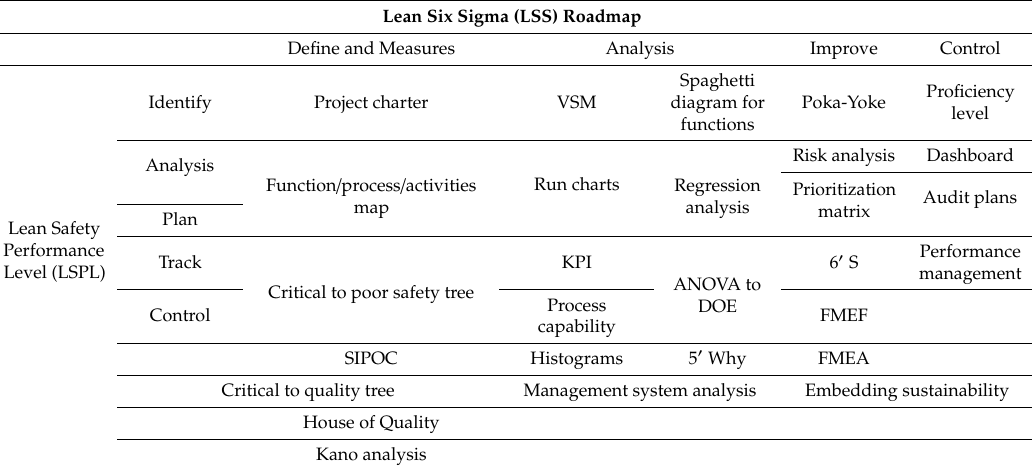
Table 9. The common tools between Lean Six Sigma (LSS) and the proposed